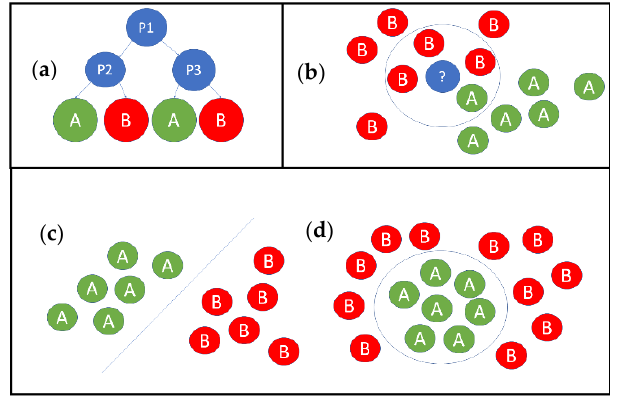
Figure 4. Principles of the machine learning methods: ( a ) decision tree; ( b ) KNN classifier and ( c ) linear support vector machine and ( d ) non-linear support vector